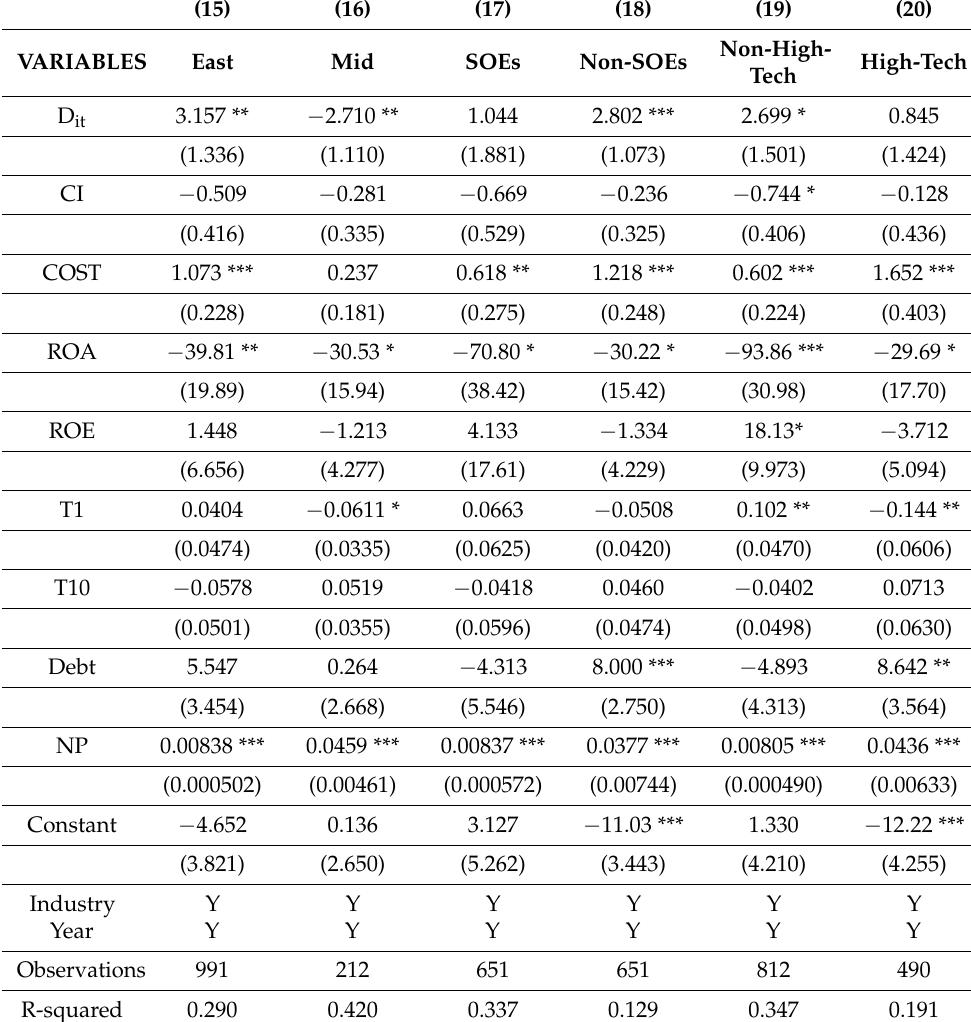
Table 6. Results of heterogeneity